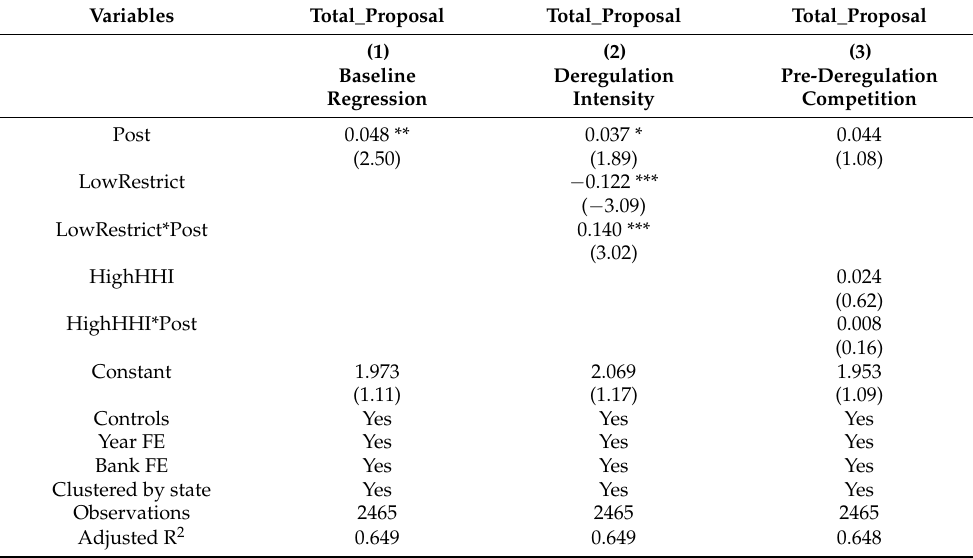
Table 5. Bank branching deregulation and the number of proposals voted